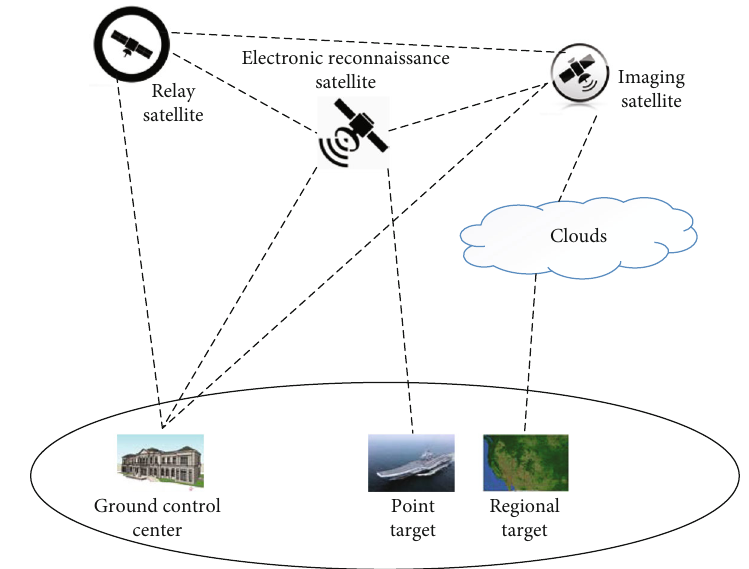
Figure 4: Diagram of earth observation satellite